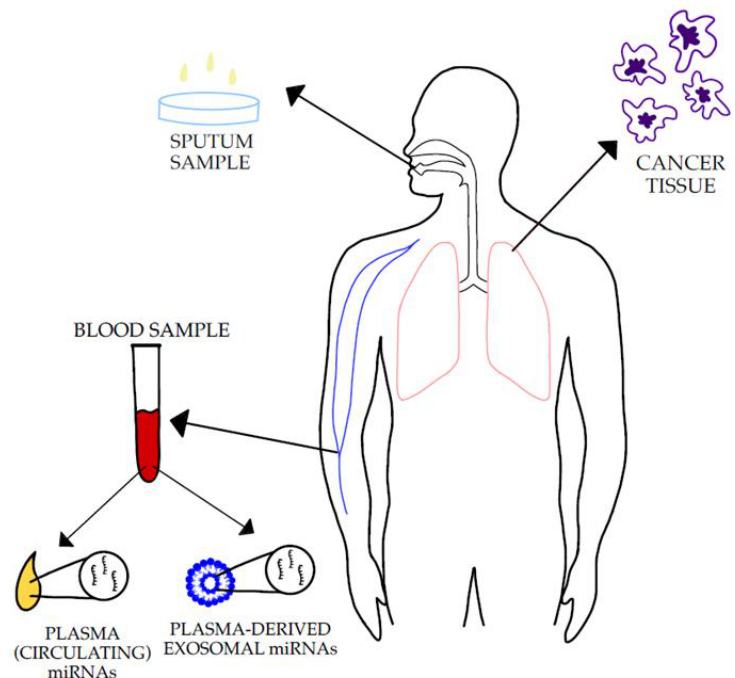
Figure 1. The figure illustrates the sample types in which the miRNAs’ expression levels can be measured [7,11,23,33 –